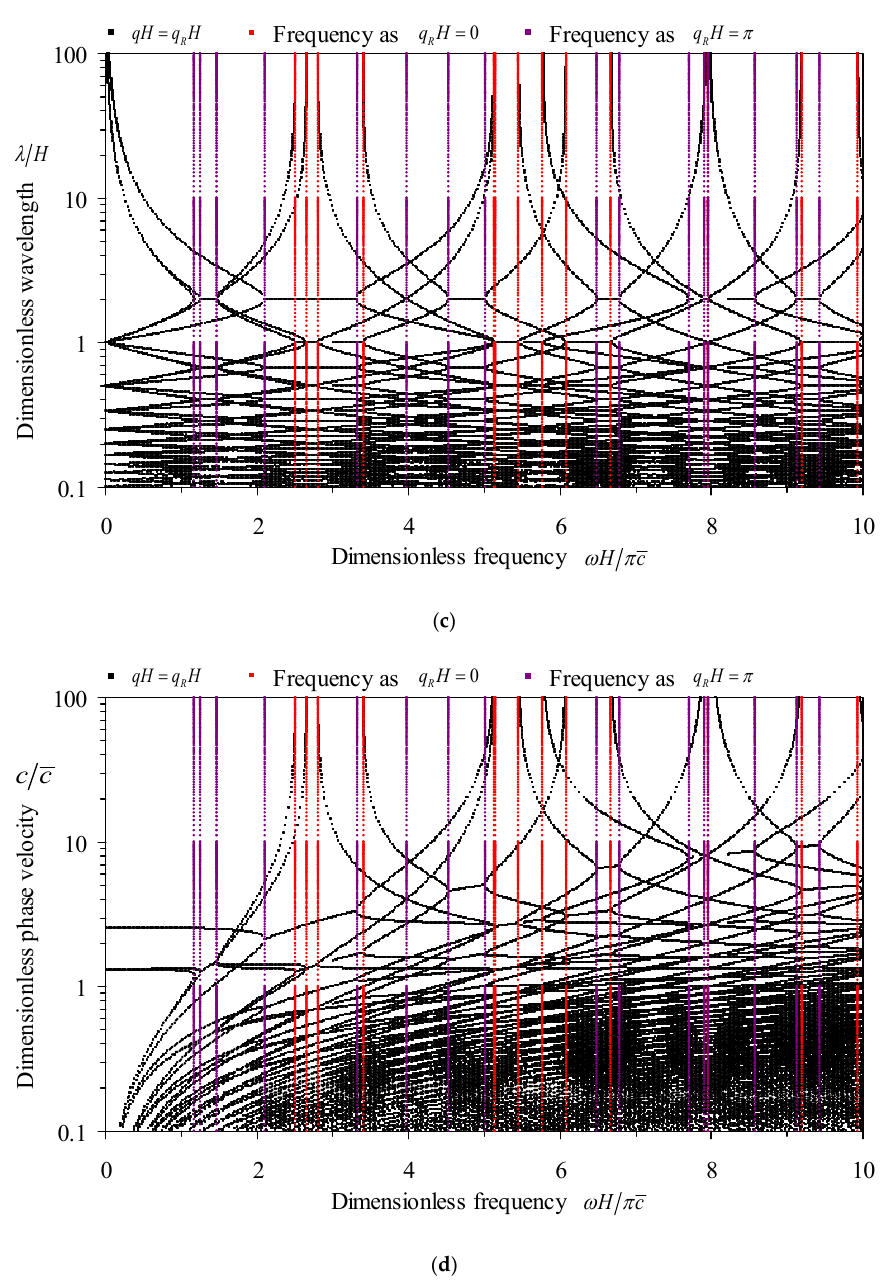
Figure 10. The comprehensive frequency-related dispersion curves of the elastic waves in periodic Figure 10. Glass-Brass-(PZT-5H 2 )-Brass multilayers: ( a ) The eigenvalue amplitude  spectra; ( b ) The wavenumber spectra; ( c ) The wavelength spectra; ( d ) The phase velocity spectra. wavenumber spectra; ( c ) The wavelength spectra; ( d ) The phase velocity